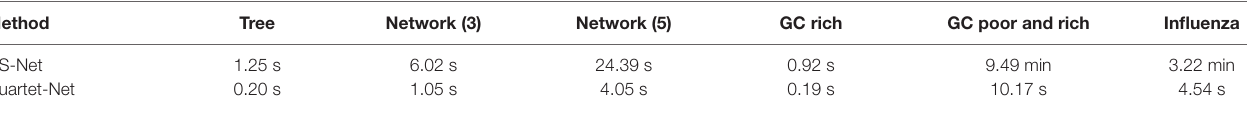
TABLE 4 | A comparison of runtime between QS-Net and Quartet-Net on all data sets.